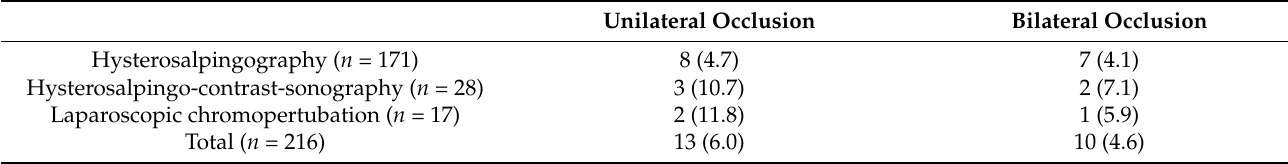
Table 2. The prevalence of Fallopian tubal occlusion according to the technique